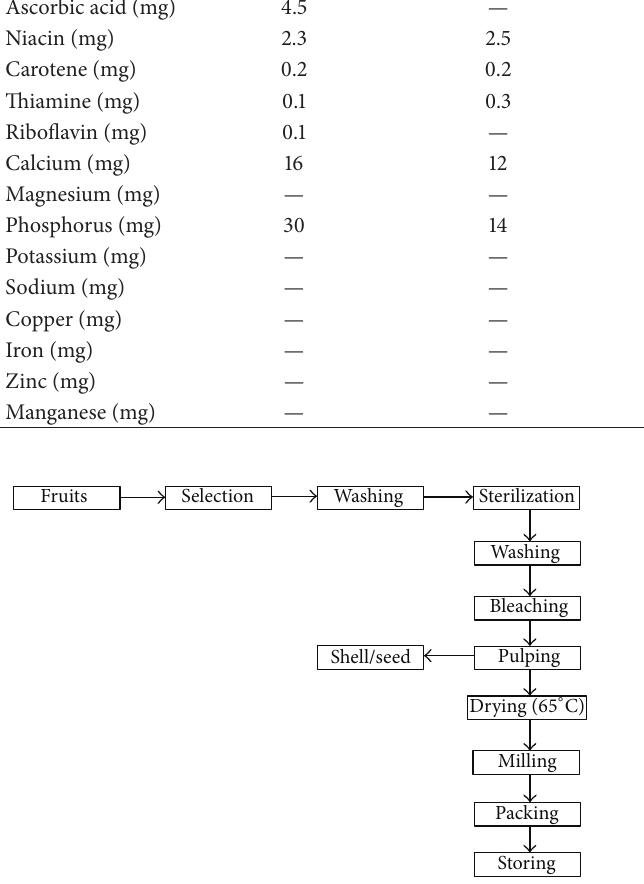
Figure 1: Processing of cubiu fruits to obtain the flour as described by da Silva Filho et al.